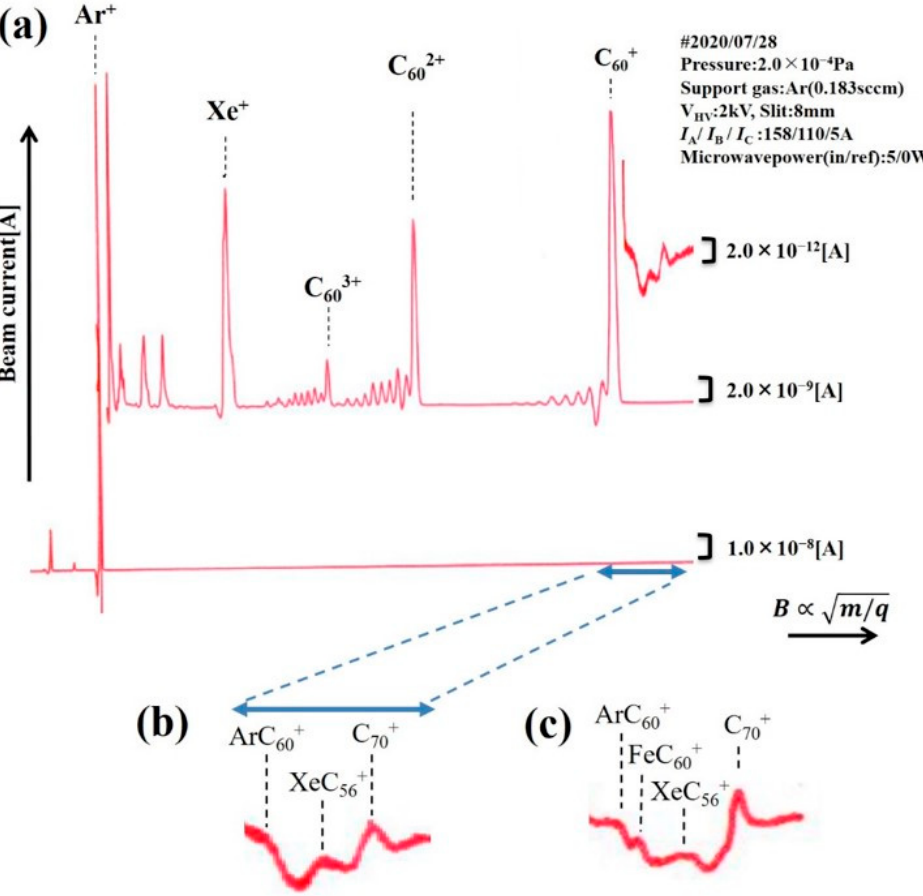
Figure 6. The spectrum obtained when only fullerene was introduced without iron vapor ( a ), and ( b ) for comparing that with ion vapor in Figure 4 (and Figure 5b) ( c ).